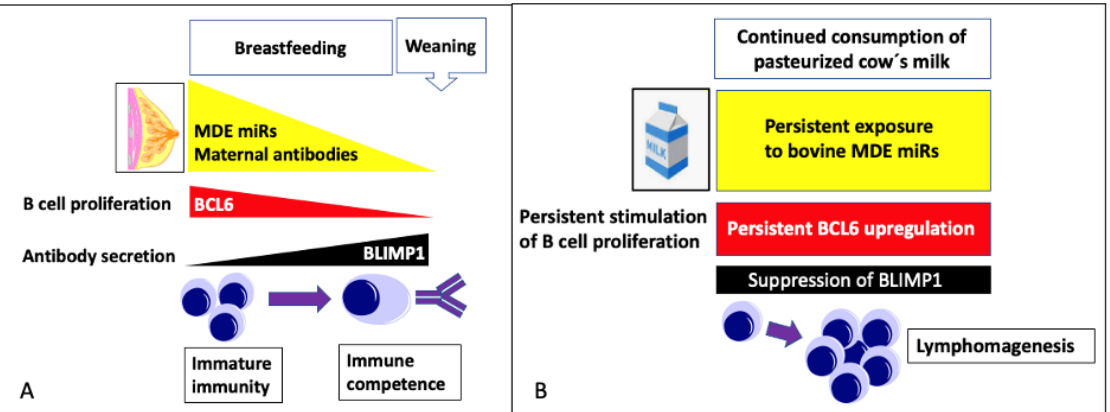
Figure 4. ( A ) Physiological interaction of human milk-derived exosomes (MDEs) and their microRNAs (miRs) in B lymphocyte proliferation via epigenetic upregulation of B cell lymphoma 6 (BCL6) and suppression of B lymphocyte-induced maturation protein 1 (BLIMP1), which suppresses B cell differentiation and antibody secretion. The neonatal immune system is immature and neonatal B cells are in a hyperproliferative undifferentiated state. The majority of specific antibodies are of maternal origin and are supplied via breastfeeding. Weaning, the physiological fading of MDE miRs, induces a key switch in milk-driven epigenetic regulation enhancing BLIMP1 expression and promoting antibody secretion by the infant’s matured immune system. ( B ) Persistent consumption of pasteurized cow’s milk maintains MDE miR-mediated epigenetic signaling promoting BCL6 expression and suppressing BLIMP1 expression, thus maintaining the hyperproliferative neonatal phenotype. Sustained proliferation is a hallmark of cancer, in this setting lymphomagenesis.